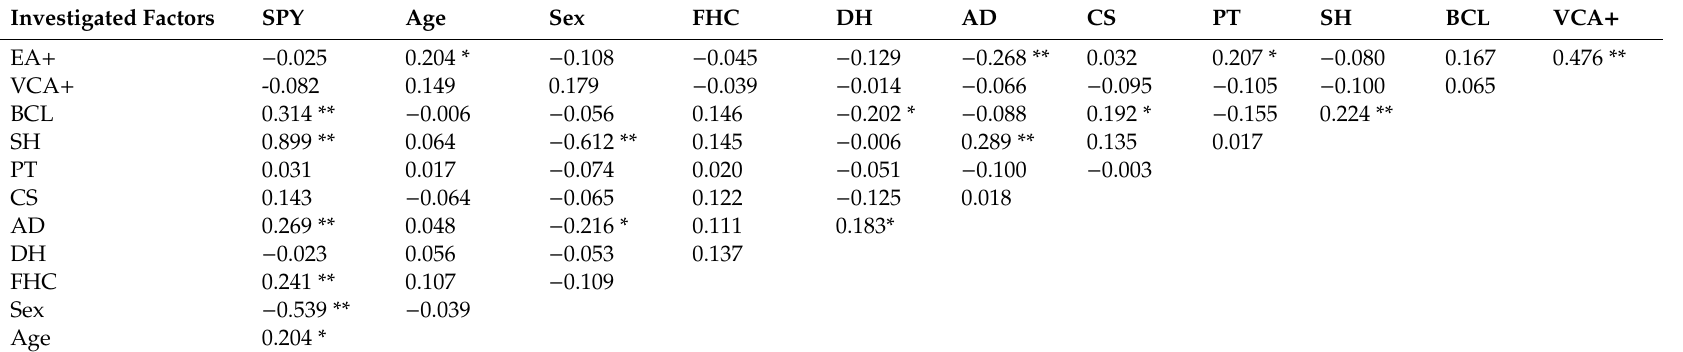
Table 4. Spearman correlation coe ffi cients between investigated factors and blood Cd level with NPC (n =